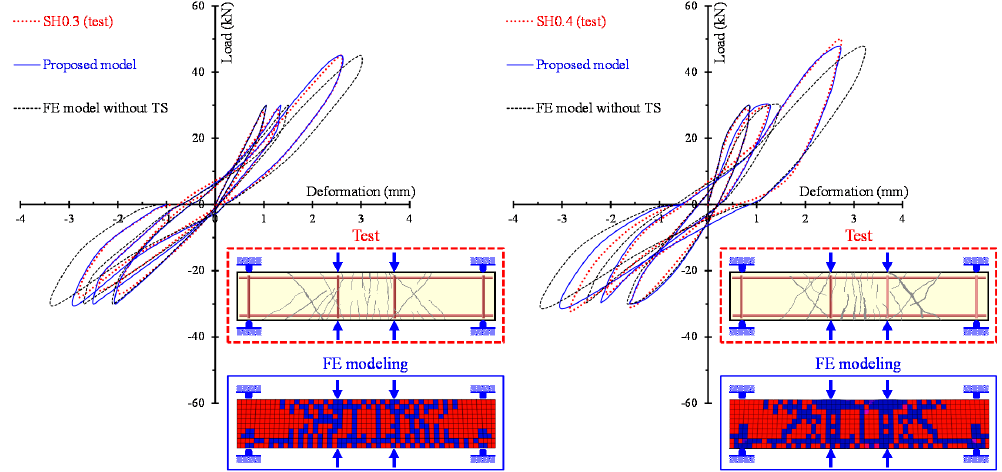
Figure 10. Comparisons between the analytical and experimental hysteretic response and cracking patterns of shear-critical beams without stirrups SH0.3 and SH0.4.